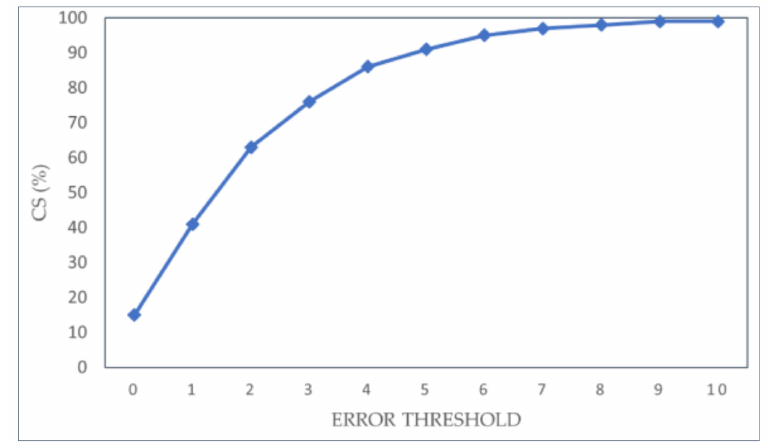
Figure 11. Cumulative score (CS) curve for the Morph dataset for the age estimation task.